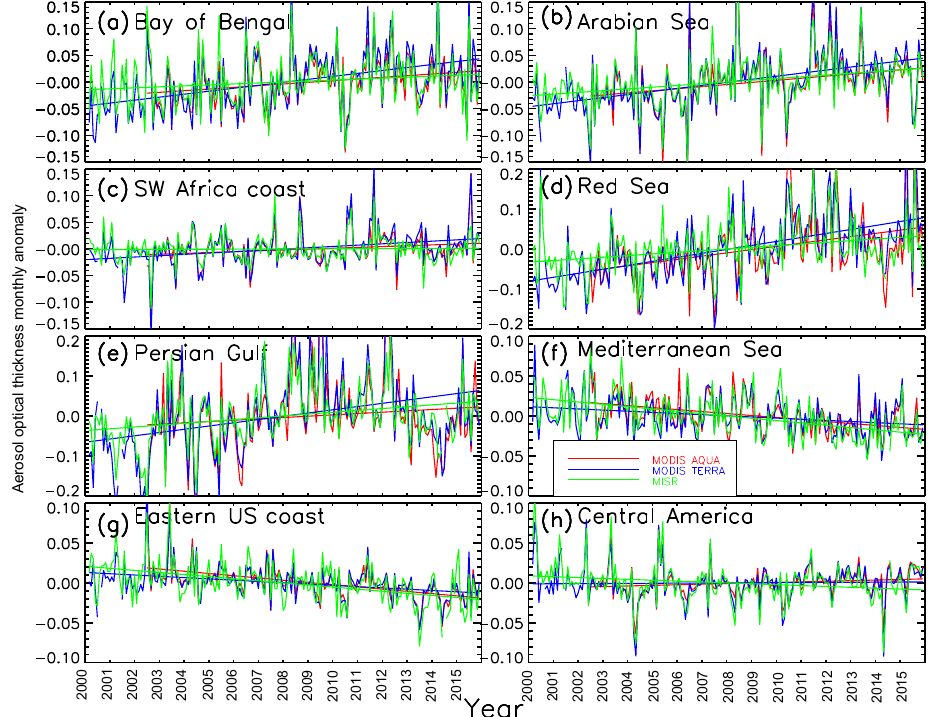
Figure 4. The deseasonalized, monthly and regionally averaged AOTs for eight selected regions utilizing MODIS C6 DT and MISR aerosol products. Straight lines are linear fits to the monthly